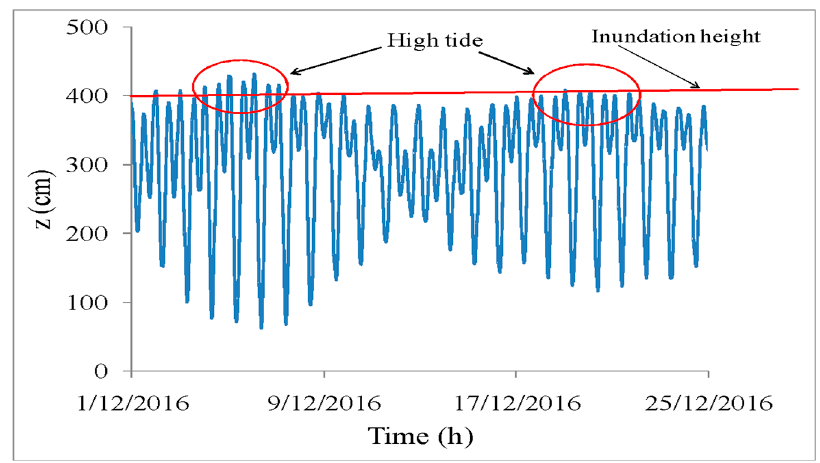
Figure 5. Time profile of water level variation at Vung Tau station in December 2016.